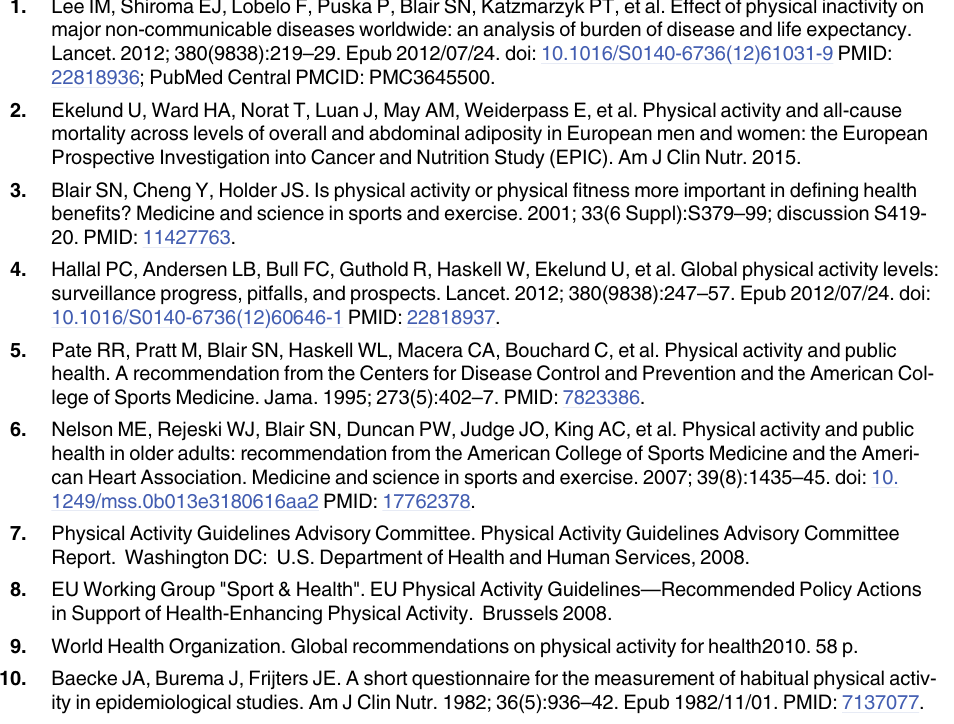
S3 Table. Results from the binary logistic regression model examining the association between meeting the 30 min.d-1 physical activity recommendation and predictor variables in 539 men and 748